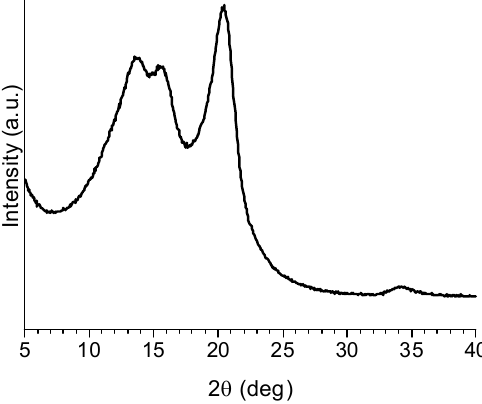
Figure 9. X ‐ ray powder diffraction profile of entry 8. Figure 9. X-ray powder diffraction profile of entry